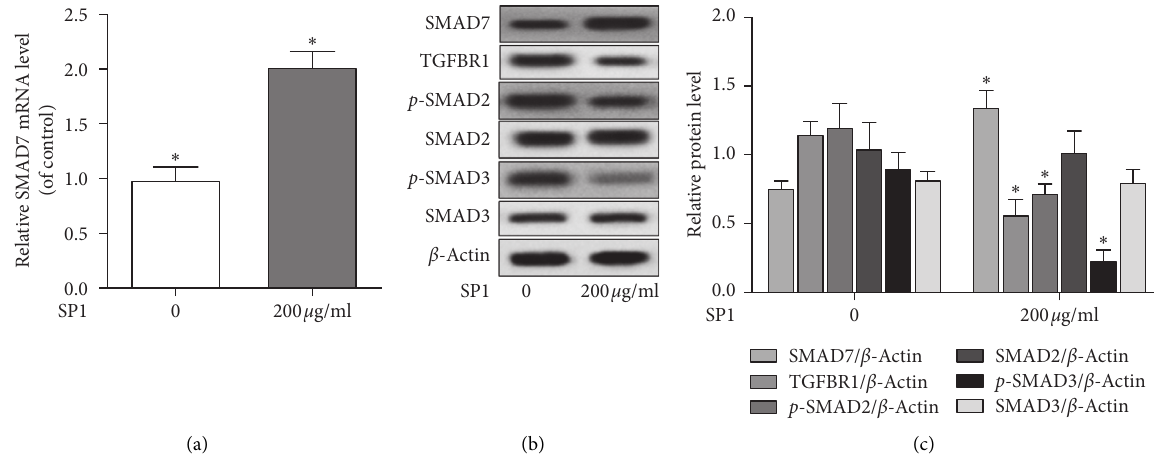
Figure 6: (a) The expression of SMAD7 mRNA in MGC-803 cells of the control group (SP1 0 μ g/ml) and SP1 treatment group (200 μ g/ml) for 72h was detected by qRT-PCR. (b) The protein level of SMAD7 in MGC-803 cells of the control group (SP1 0 μ g/ml) and SP1 treatment group (200 μ g/ml) for 72h was detected by Western blot. Compared with the control group, ∗ P < 0 .